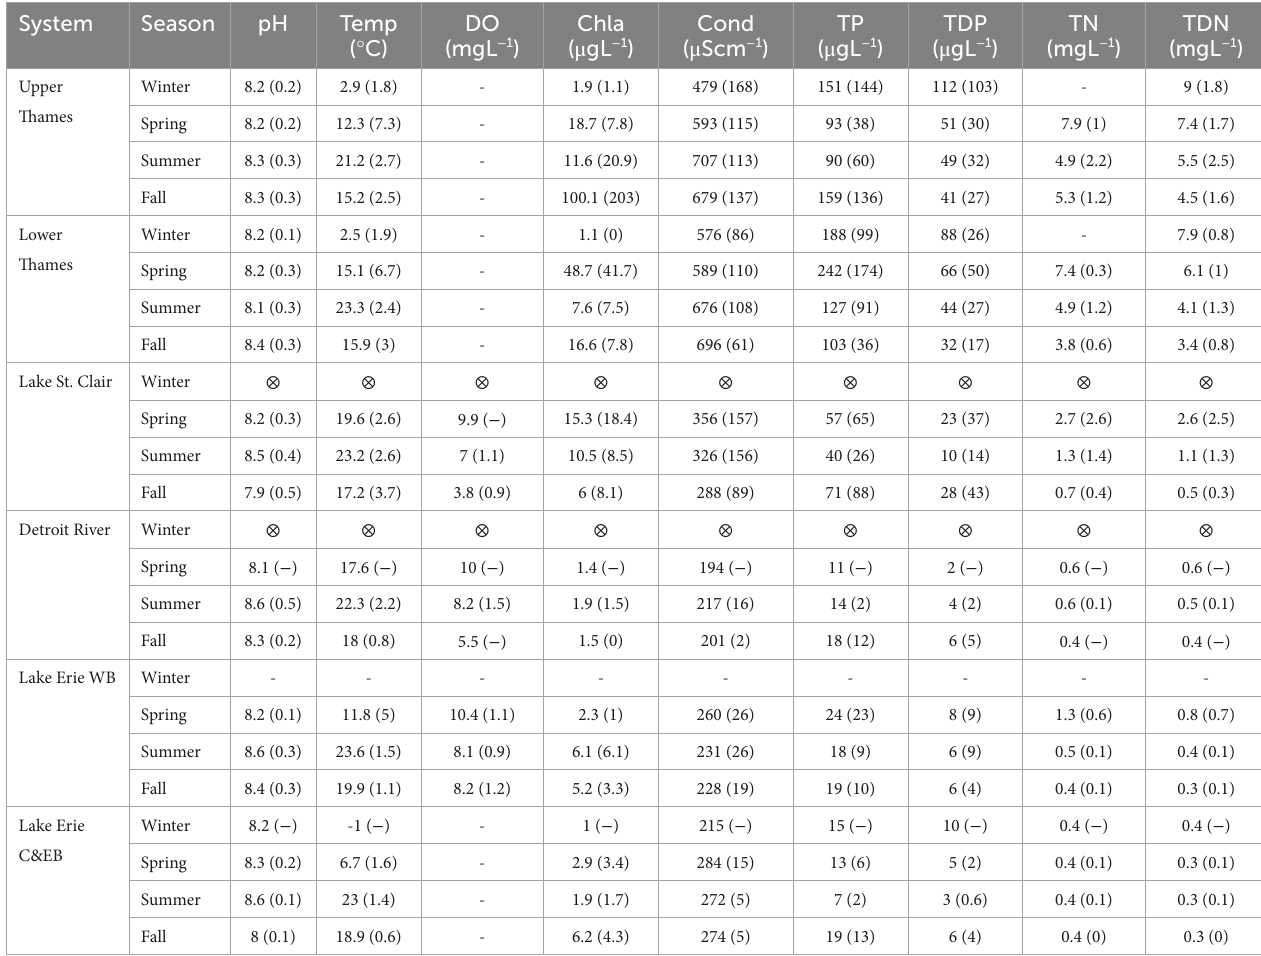
TABLE 1 Average (SD in brackets) of the environmental variables for each ecosystem and across seasons: pH, temperature (Temp), dissolved oxygen (DO), conductivity (Cond), total phosphorus (TP), total dissolved phosphorus (TDP), total nitrogen (TN), total dissolved nitrogen (TDN), chlorophyll a (Chla).